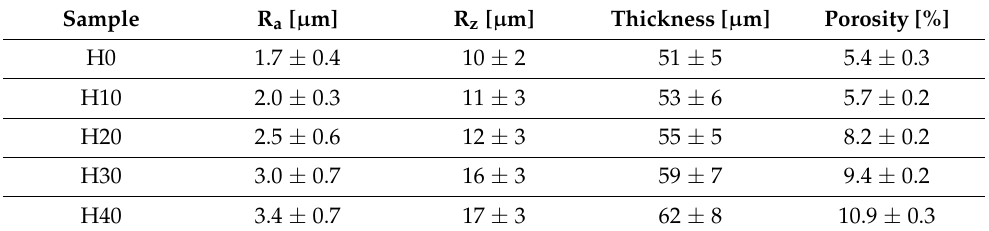
Table 1. Thickness and roughness parameters of the studied samples.